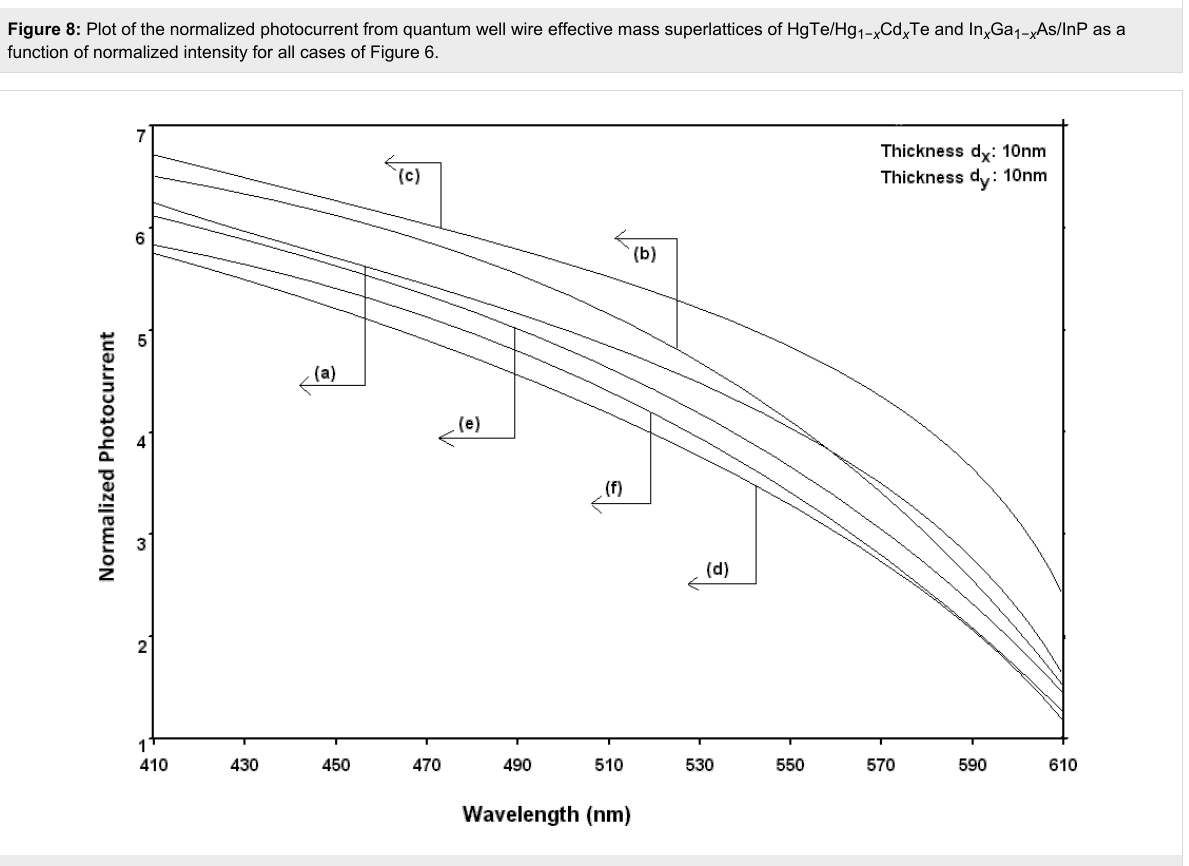
Figure 9: Plot of the normalized photocurrent from quantum well wire effective mass superlattices of HgTe/Hg 1 − x Cd x Te and In x Ga 1 − x As/InP as a function of light wavelength for all cases of Figure